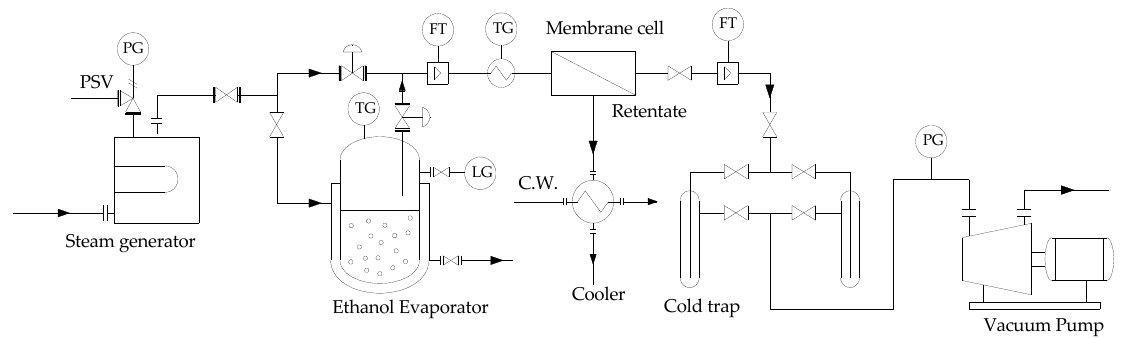
Figure 2. Schematic diagram of the experimental apparatus for VP.